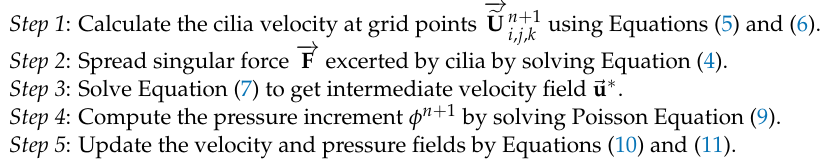
Table 2. The numerical procedure for each time step of the present